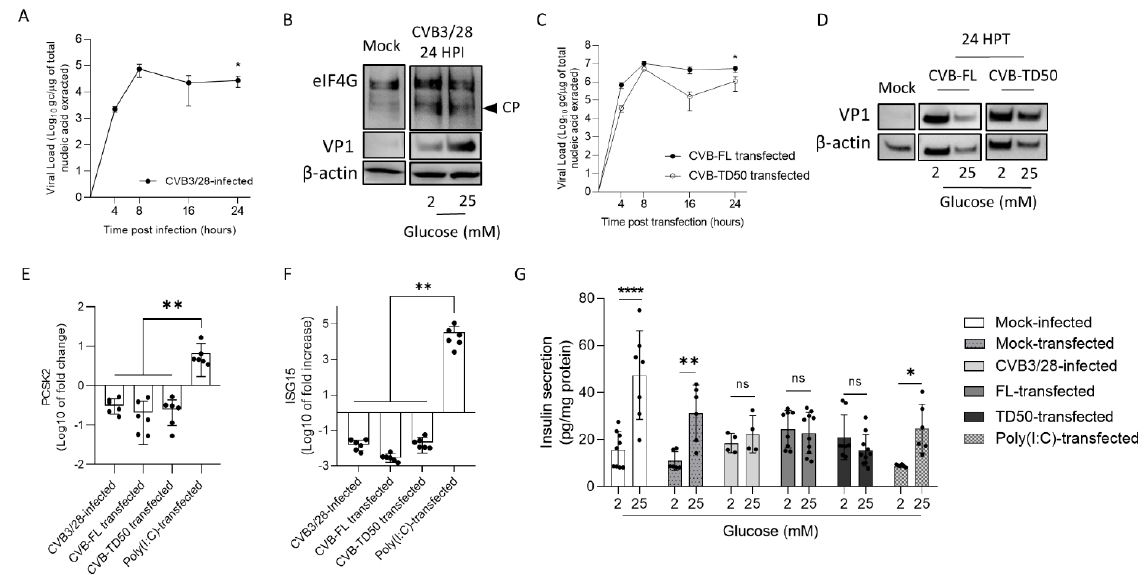
Figure 5. Infection by CVB3/28 and transfection by CVB-TD50 RNA forms decrease PCSK2 mRNA expression and abolish the insulin response to glucose stimulation in beta cells of rodents. ( A ) Infectious CVB3/28 virus loads in the supernatant of INS-1 cells at indicated time points post-infection. ( B ) Western blot analyses showed the cleavage of eIFG4, a eukaryote translation factor, viral protein 1 (VP1) and β -actin expression in mock-infected and CVB3/28-infected pancreases at 24 h post-infection (24 HPI) in INS-1 cells. ( C ) Kinetics of viral RNA replication activity after CVB-FL and CVB-TD50 RNA forms (1 µ g) transfection of INS-1 cells measured by RT-qPCR. ( D ) Western blot analysis of CVB3/28 viral protein 1 (VP1) and β -actin in mock-infected and CVB-FL/TD50-transfected INS-1 cells at 24 h post-transfection (24 HPT). ( E ) PC2 (PCSK2) mRNA level fold-changes (RT-qPCR) in INS-1 cells infected with CVB3/28, or transfected with CVB-FL/TD50 or Poly (I:C). ( F ) ISG15 mRNA level fold-changes (RT-qPCR) in INS-1 cells infected with CVB3/28, or transfected with CVB-FL/TD50 or Poly (I:C). ( G ) Glucose stimulated the insulin secretion assay of INS-1 cells following infection of CVB3/28, transfection of CVB RNA forms or Poly (I:C), or mock-infected/transfected cells (triplicate). Data are expressed as pg of insulin in supernatant per mg of total protein content. ANOVA test (panel ( G )) or Mann–Whitney U test (panels ( A , C , E , F )); *: p < 0.05; **: p < 0.01; ****: p < 0.0001. Not specified or ns: non-significant. Data represent mean +/ − SD of three independent experiments. CVB-FL/TD: full-length or 5 (cid:48) terminally deleted coxsackievirus. HPI: hours post-infection. HPT: hours post-transfection. CP: cleavage product. VP1: viral capsid protein 1. eIF4G: Eukaryotic translation initiation factor